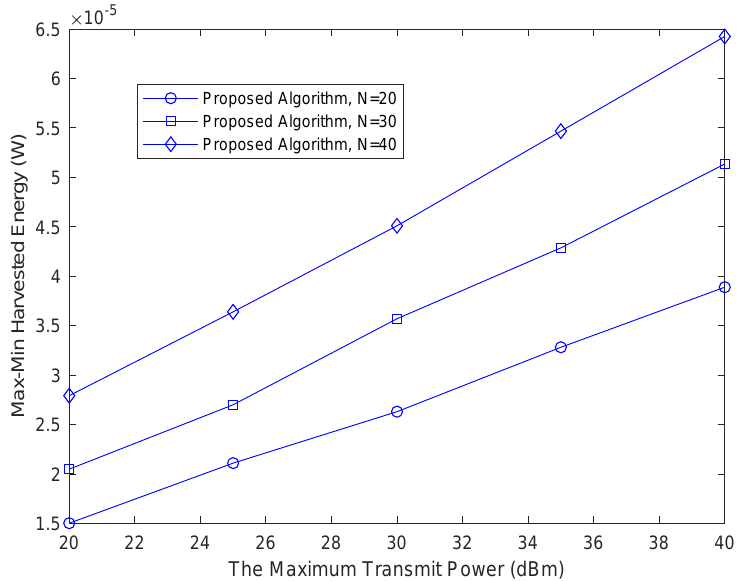
Figure 3. Relationship between max-min harvested energy and the maximum transmit power of base